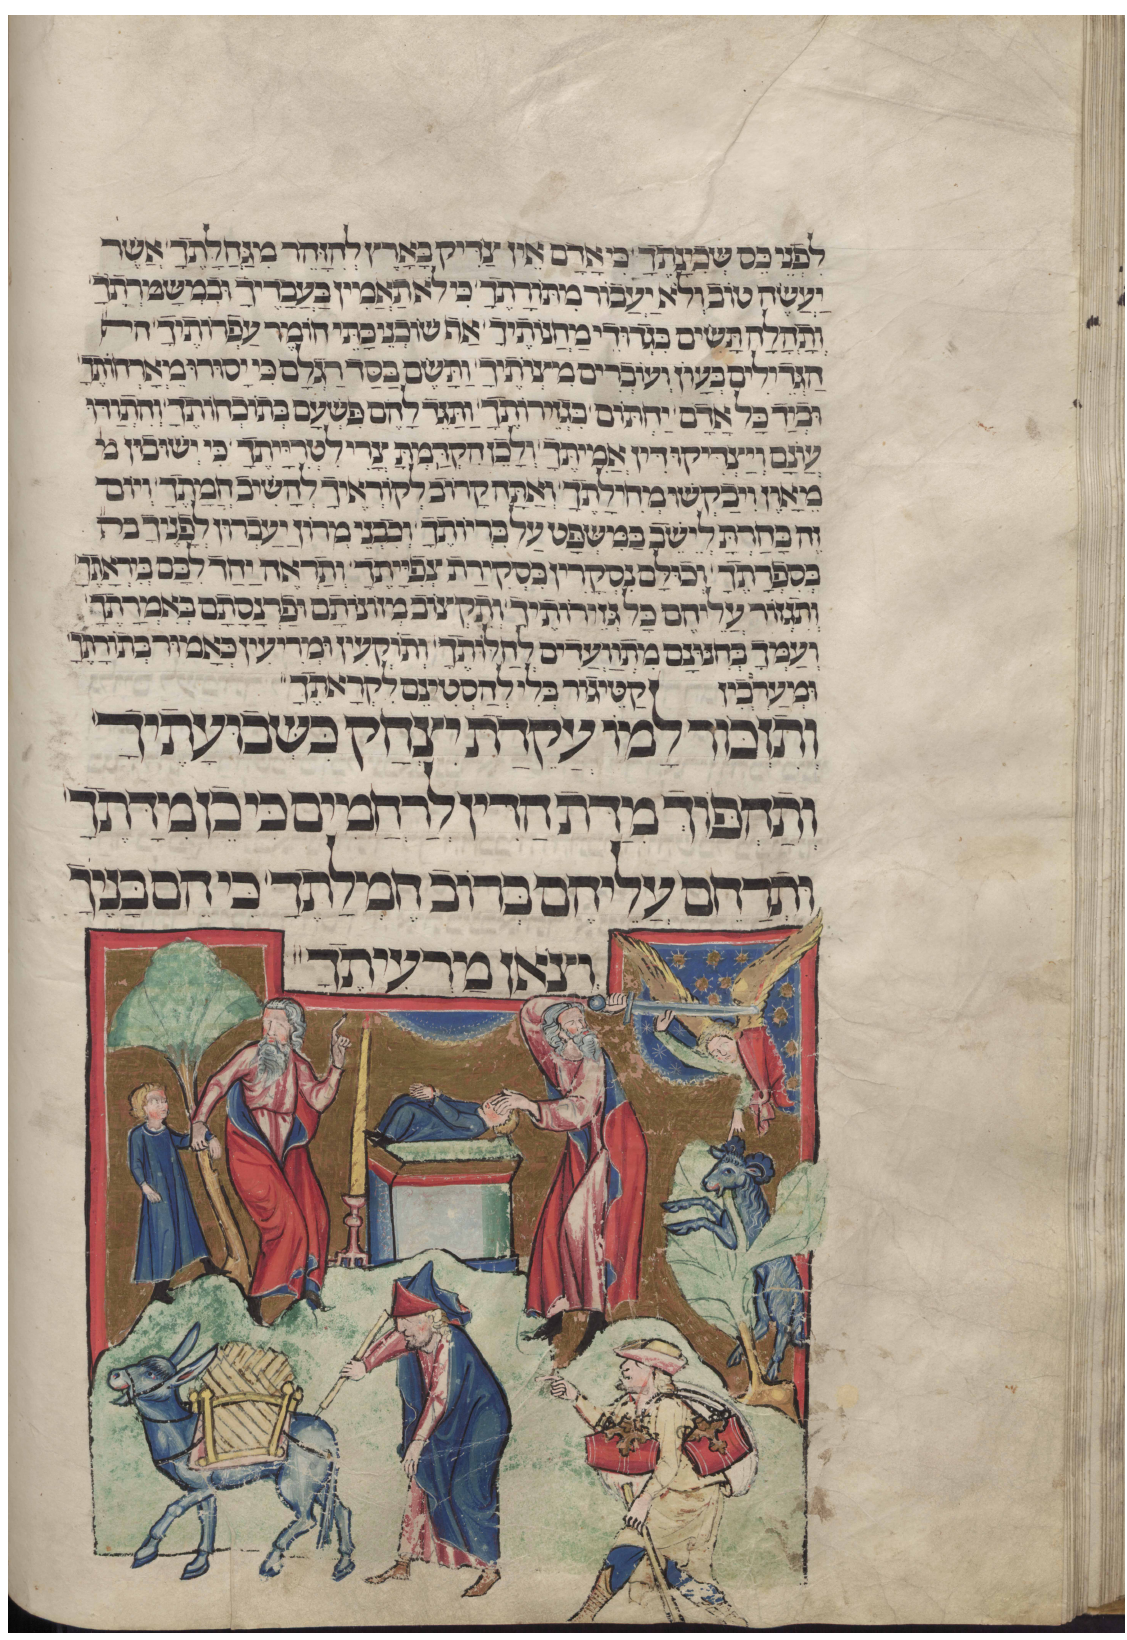
Figure 2 Wroclaw Maḥzor, Esslingen, between 1290 and 1293 (Wroclaw, State and University Li- brary, Ms. Or. I 1, f.